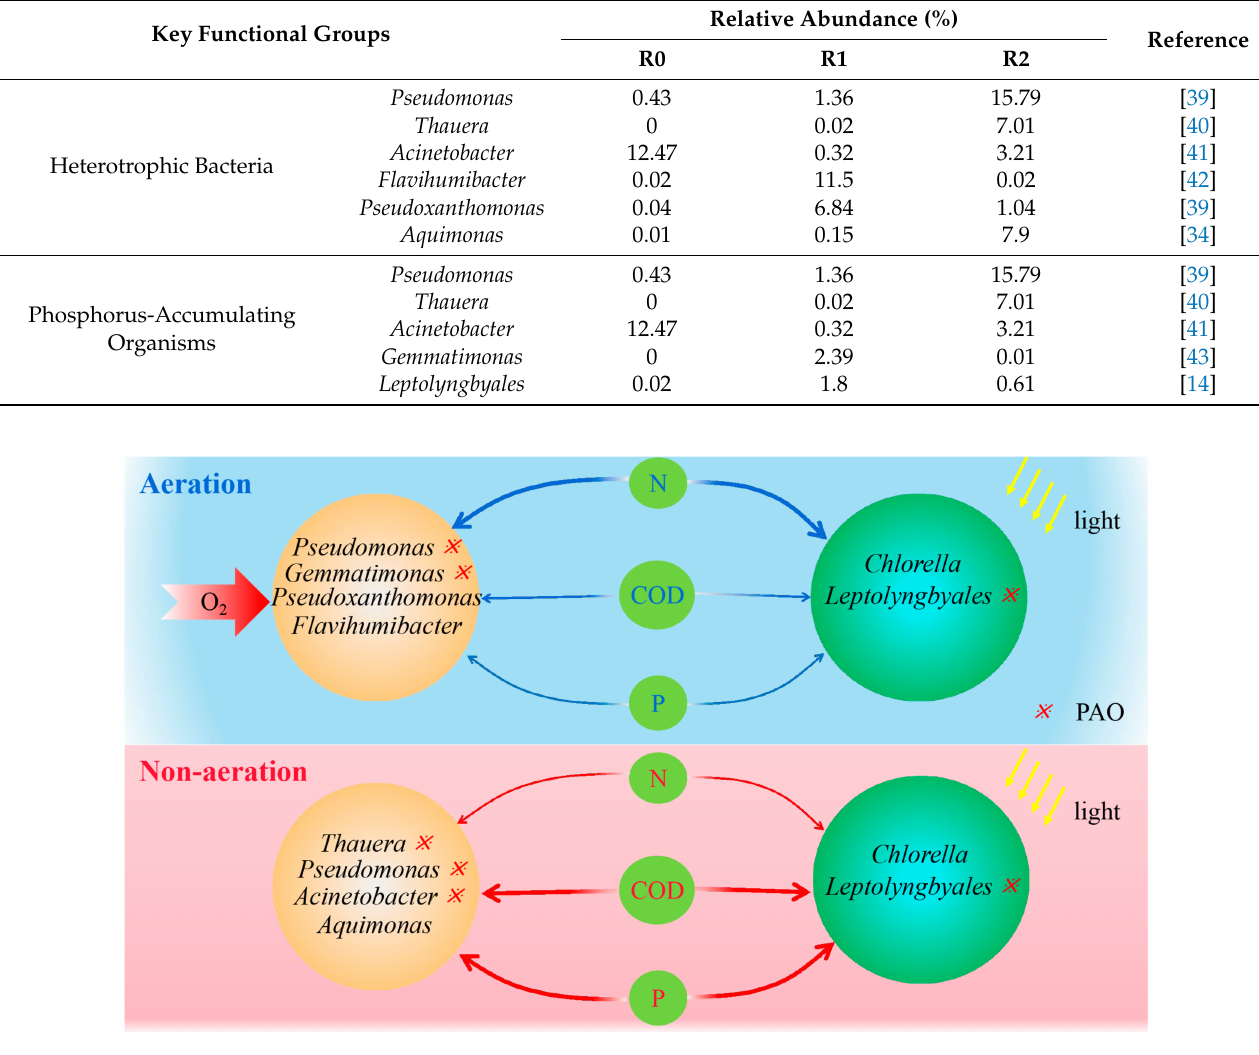
Figure 4. Possible pollutant removal pathways based on key functional microbial groups in the microalgal-bacterial granular sludge process under aeration and non-aeration